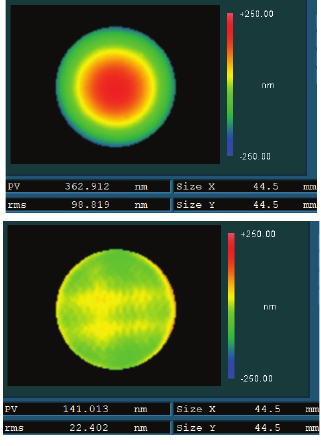
Figure 2. Interferometric measurement of plano before and after correction